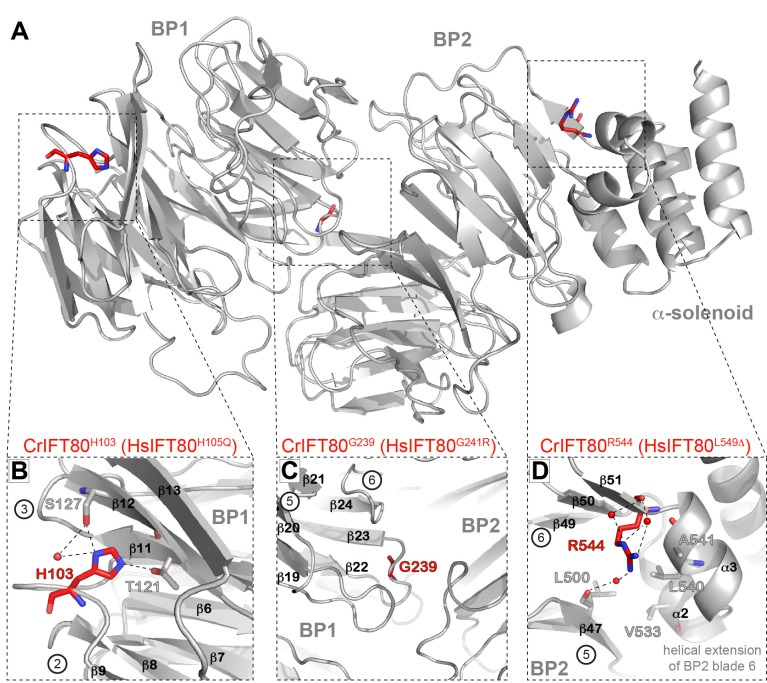
Structural analysis of IFT80 residues mutated in human ciliopathy patients.(A) Localization of three residues found to be mutated in patients with skeletal cilipathies in the structure of CrIFT80. The overall IFT80 structure is shown in grey in cartoon representation, the amino-acids mutated in the patients are shown as red sticks. The dashed boxes indicate the region shown in detail in (B–E). (B) CrIFT80 H103 (corresponding to the human H105Q mutation) is located in a loop connecting BP1 blades 2 and 3, and participates in BP1 stability by forming electrostatic contacts with T121 and S127 in blade 3. (C) CrIFT80 L141 (corresponding to the human L143S mutation) is located in blade 3 of BP1and contributes to BP1 stability by hydrophobic interactions with a number of conserved hydrophobic residues in blade 4 (L173, K171, L160). (D) CrIFT80 G239 (corresponding to the human G241R mutation) sits in a loop in blade 6 of BP1 and is oriented towards the BP1/BP2 interface. Due to limited space the mutation to an arginine will alter the relative orientation of BP1 and BP2. (E) CrIFT80 R544 (corresponding to the human L549Δ mutation) is located at the beginning of a strand in BP2 blade 6, in close proximity to the helical blade six extension which keeps the IFT80 α-solenoid in place by hydrophobic contacts.